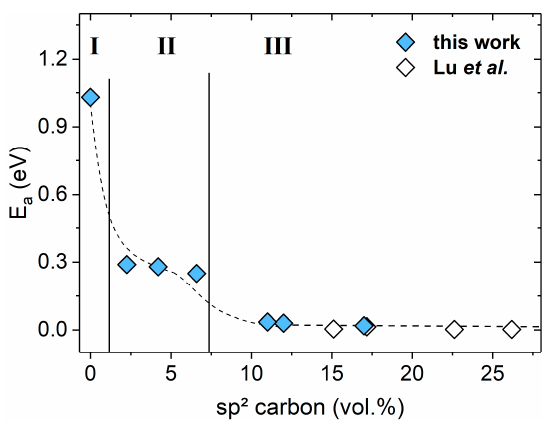
Figure 8. Plot of E a as a function of the sp 2 carbon content in SiOC/C, the empty symbols represents data published by Lu et al. [34]. The dotted line is shown only as a guideline, it does not represent any fit of the data. I, II and III represent the three conduction regimes as described in text